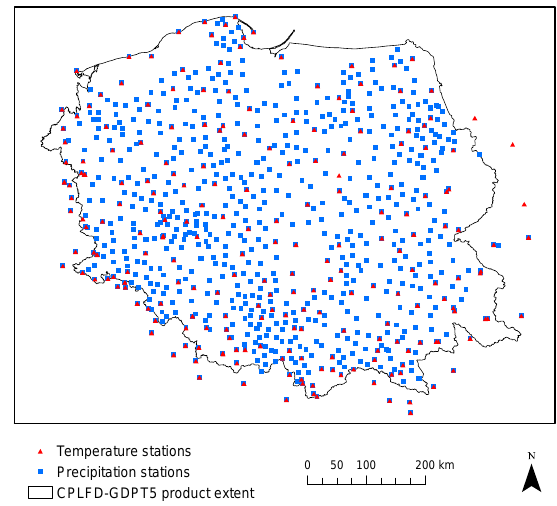
Figure 4. Spatial distribution of meteorological stations for temper- ature and precipitation used for interpolation of the CPLFD-GDPT5